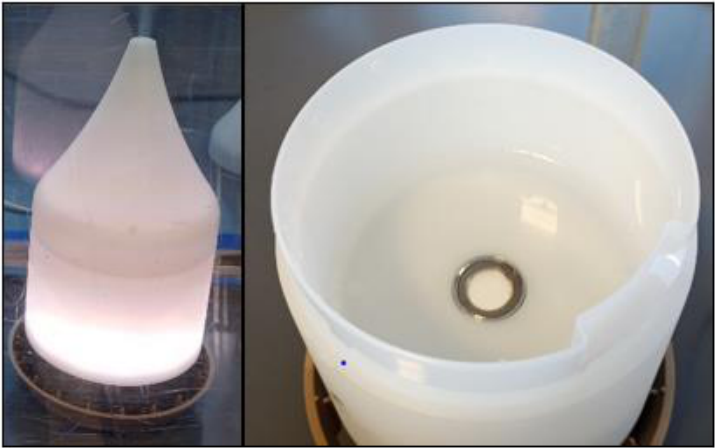
Figure 3. Desert Mist™ Ultrasonic Diffuser.